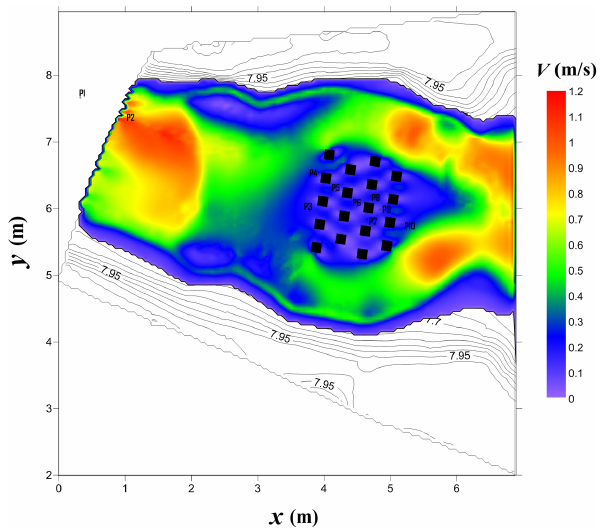
Figure 8. A snapshot of the distribution of velocities in an experi- ment with aligned buildings as produced by